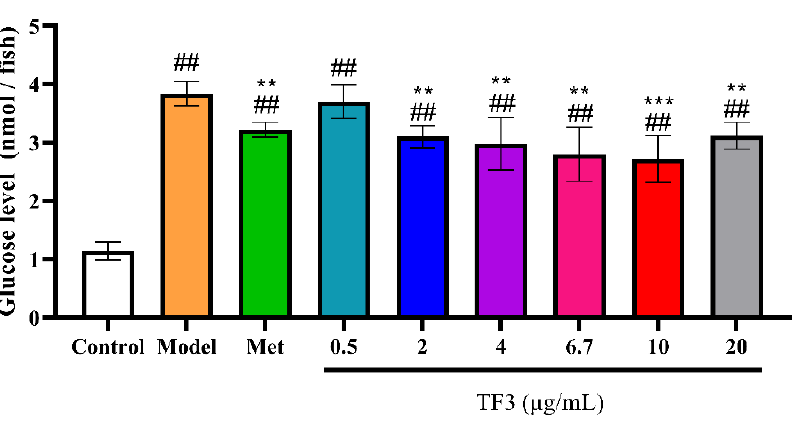
Figure 3. TF3 treatment reduced glucose level in zebrafish. Results were expressed as the mean ± SD ( n = 5). Control, water culture; model, water with 1 μM alloxan and 4% glucose culture for 24 h; TF3, water with different concentrations of TF3 (0.5, 2, 4, 6.7, 10, and 20 μg/mL) treating for 24 h after alloxan-treatment; Met, water with metformin hydrochloride (10 μg/mL) treating for 24 h after alloxan-treatment. ## p < 0.01 versus control group. ** p < 0.01 versus model group, *** p < 0.001 versus Model group.